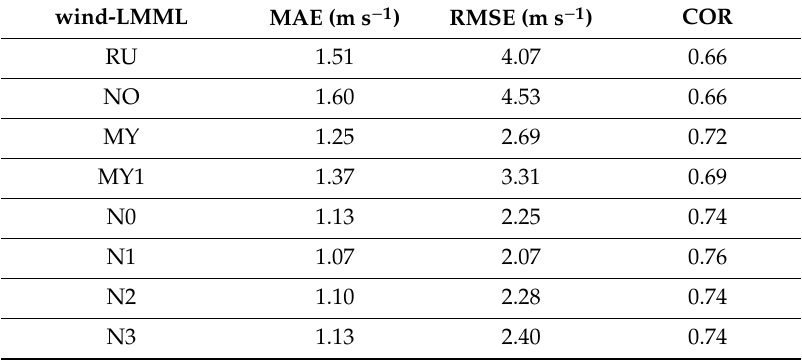
Table A9. Mean absolute error (MAE), root mean square error (RMSE), and correlation coe ffi cient (COR) for surface wind at Luqa (Malta); meteorological aviation reporting (METAR) station code =